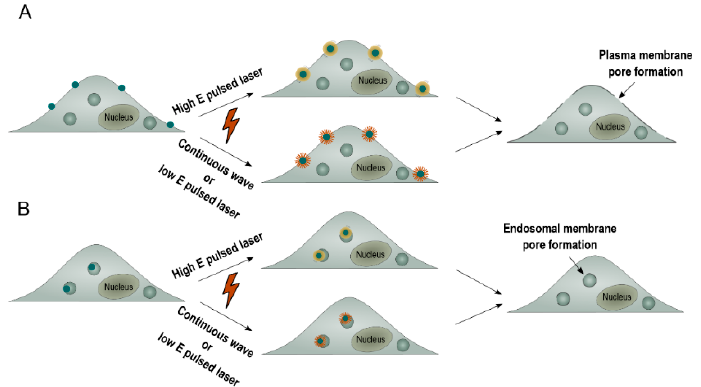
Figure 2. The application of plasmonic NPs to overcome intracellular barriers. ( A ) NP-sensitized plasma membrane photoporation. Cells are incubated with plasmonic NPs to allow attachment of the NPs to the plasma membrane. Next, laser irradiation causes the formation of VNBs (high energy pulsed laser) or heating (continuous wave or low energy pulsed laser). The generation of these plasmonic effects causes the formation of a pore in the plasma membrane, which allows entry of exogeneous compounds into the cell by diffusion; ( B ) light-triggered endosomal escape. Plasmonic NPs are allowed to be taken up by the cell through endocytosis. Next, laser irradiation causes the formation of VNBs (high energy pulsed laser) or heating (continuous wave or low energy pulsed laser). The generation of these plasmonic effects causes the formation of a pore in the endosomal membrane, which allows release of endocytosed cargo.